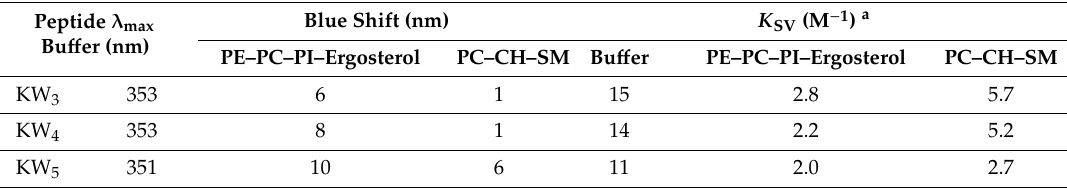
Table 2. Tryptophan emission maxima and a K SV measured in PBS (pH 7.2) or in the presence of 200 µ